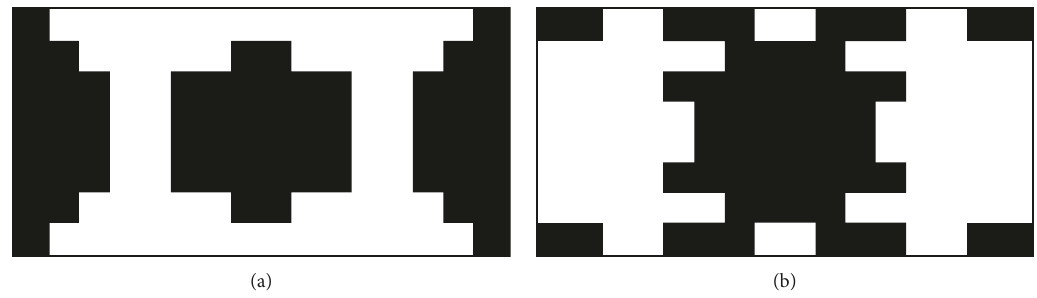
Figure 8: The optimal layouts of CLD treatment. (a) f